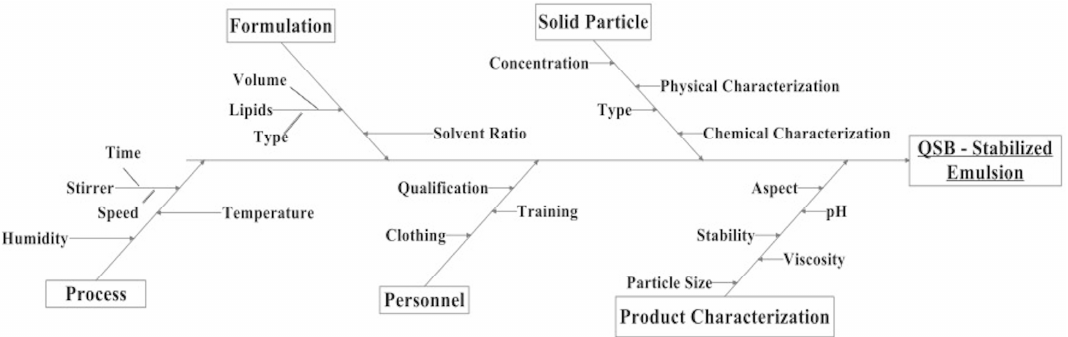
Figure 2. Ishikawa diagram illustrating factors that may have impact on the droplet size of a QSB- QSB-stabilized emulsion stabilized emulsion [29].